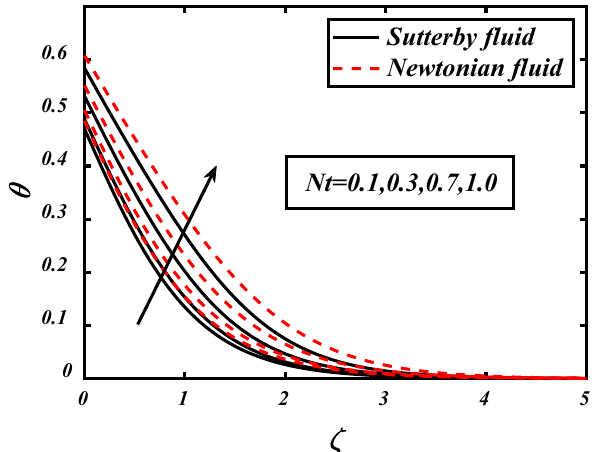
Figure 8. Expounds the impacts of Nt on θ .